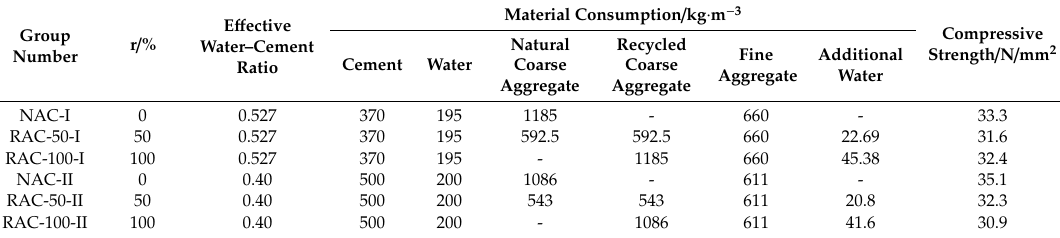
Table 2. Mix ratio of recycled aggregate concrete (RAC) and natural aggregate concrete (NAC).